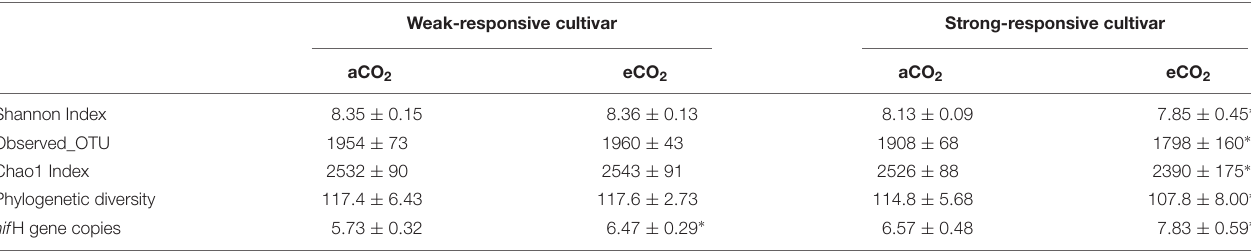
TABLE 1 | The effects of CO 2 (ambient [aCO 2 ] and elevated [eCO 2 ]) and cultivar (weak- and strong-responsive) on the α -diversity indices of diazotrophic communities and the nif H gene copy numbers (10 7 /g dw soil). Weak-responsive cultivar